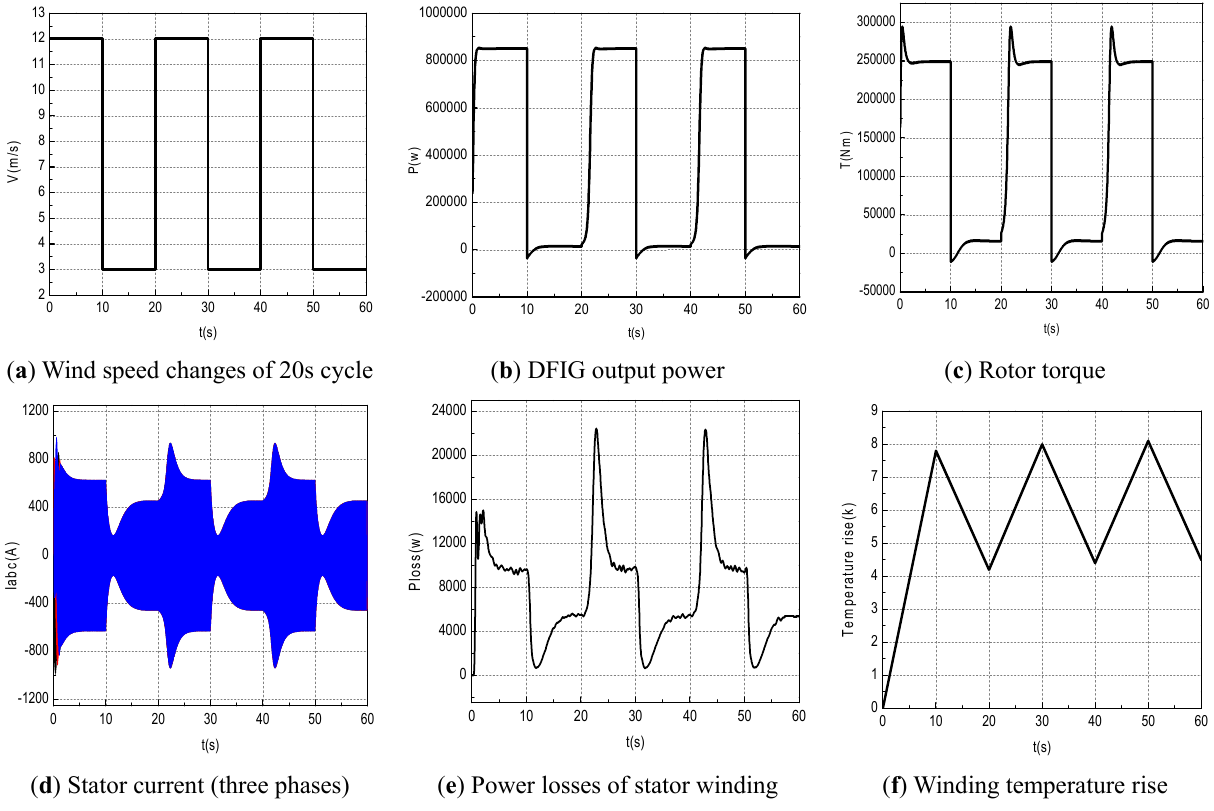
Figure 9. Mechanical, electrical and thermodynamics of the WT and DFIG stator winding under step-cycle wind speed